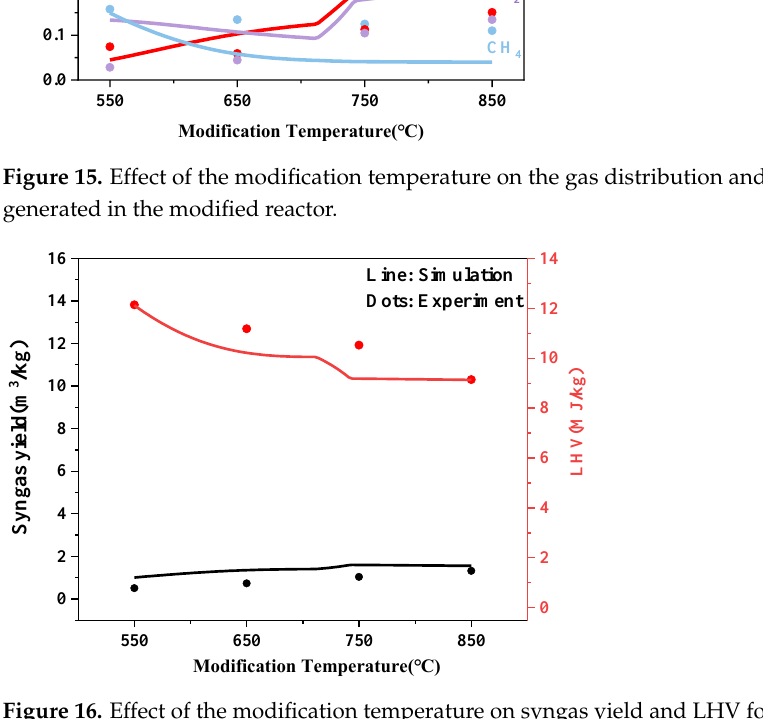
Figure 16. Effect of the modification temperature on syngas yield and LHV for the modified syn- gas.